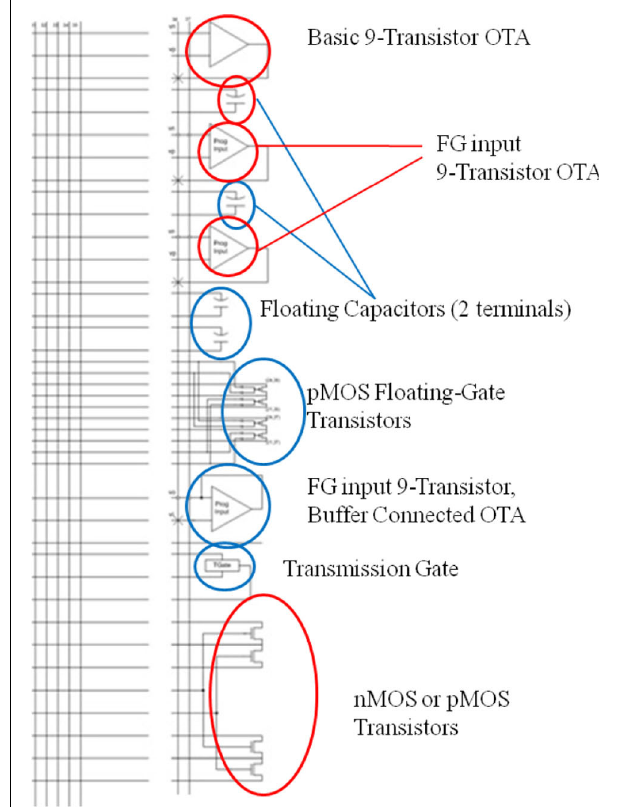
computational elements in one of the 32 computational analog blocks (CABs) present on the RASP chip. The elements used in the present design are highlighted in red. Alternating CABs have NMOS transistors and PMOS as the bottom CAB element, and although only three of the MOSFETs are used in our circuit from Figure 3 , instead of the four that are circled, this is meant to show several different combinations of these four transistors can be used to make the three transistor circuit. The top triangle elements are an OTAs showing the two inputs and output being routed back into the fabric which is a mesh of lines with switches able to connect any two lines that cross in the mesh. The element below the OTAs is a capacitor and the bottom elements circled are NMOS and PMOS available to be